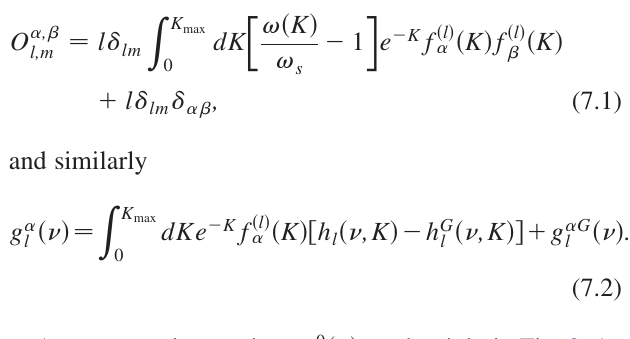
FIG. 3. Spectrum functions at the threshold current I th imaginary parts should be vanishing for the l ¼ 2